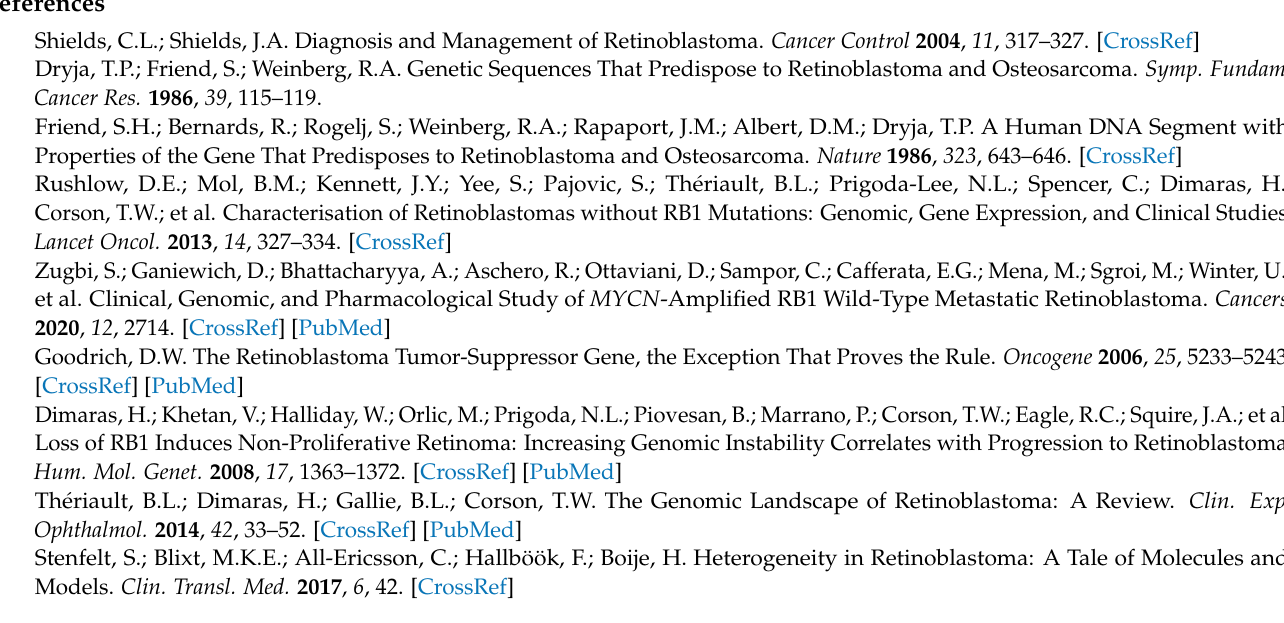
cells, Table S2: Primers used for qRT-PCR validation of identified target genes, Figure S4: qRT-PCR validation of identified downregulated metabolic genes, Figure S5: Dose response curves for MYCN Figure S6: Full immunoblots for Figures 1A, 3C and